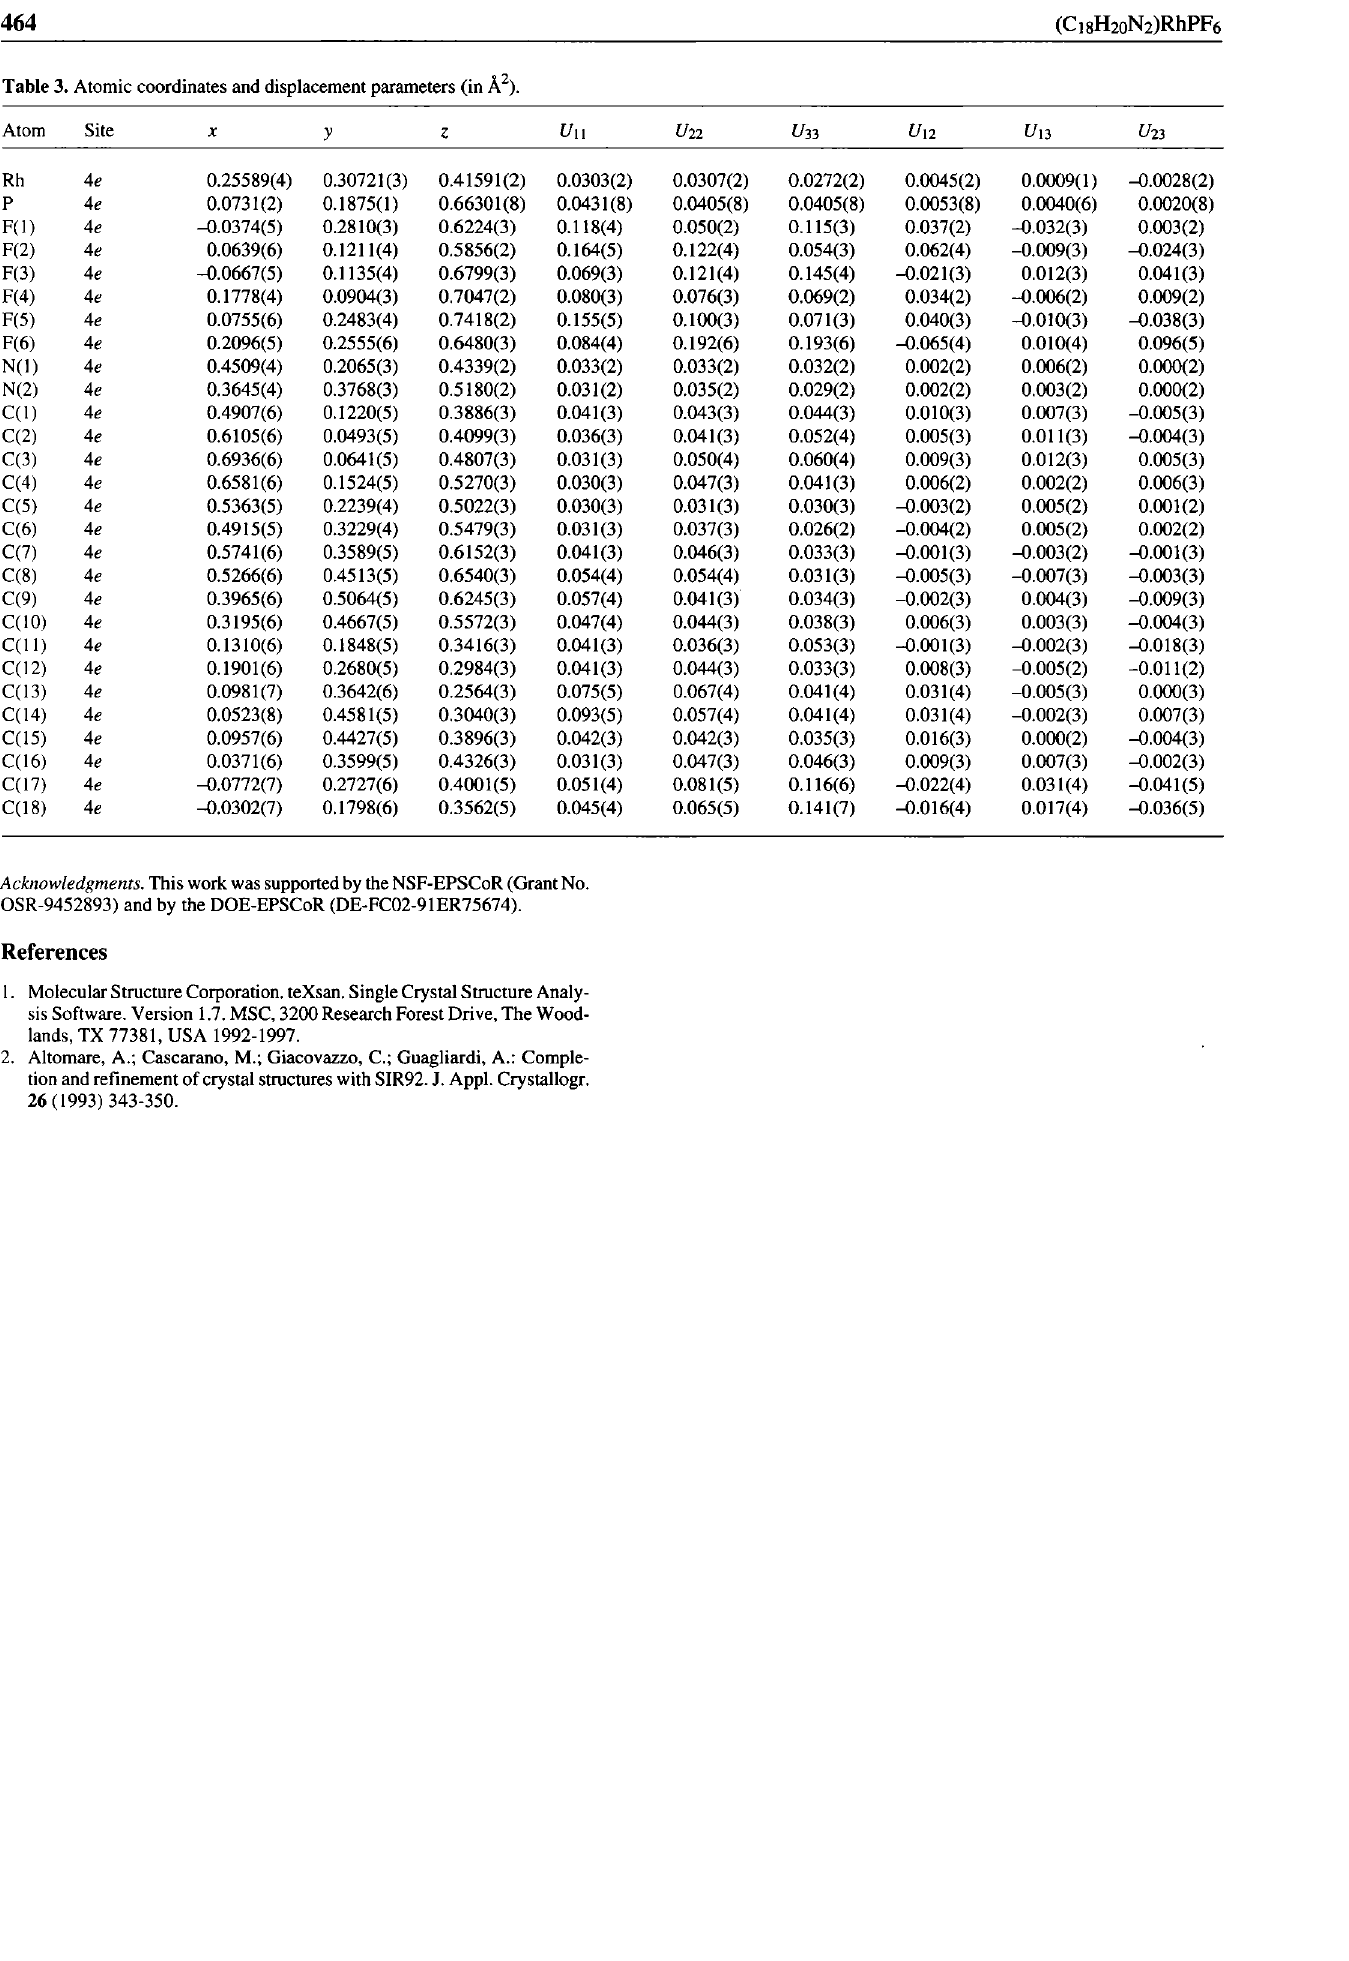
Table 3. Atomic coordinates and displacement parameters (in Ä 2